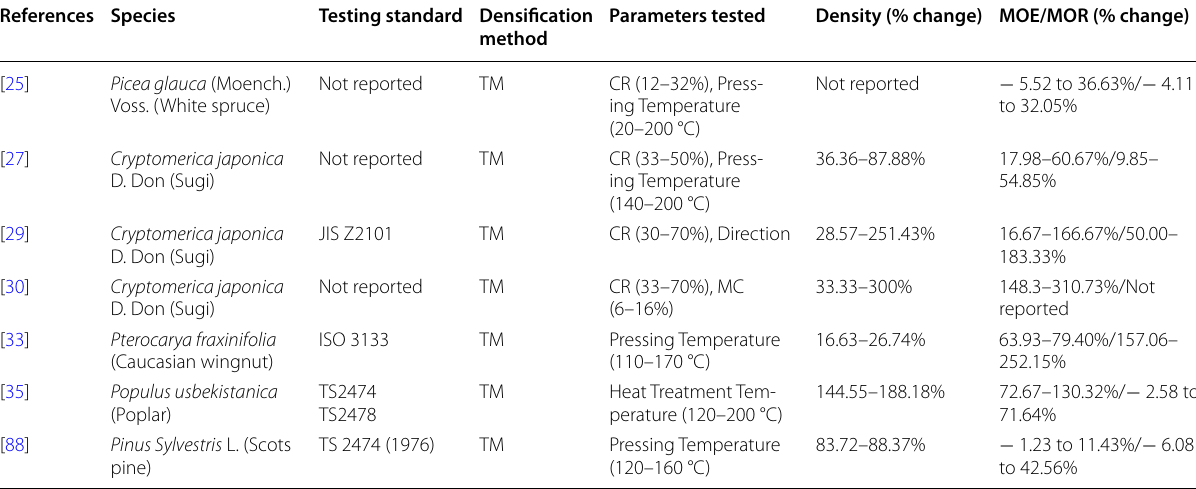
JIS Japanese Industrial Standards, ISO International Organization for Standardization, TS Turkish Standards